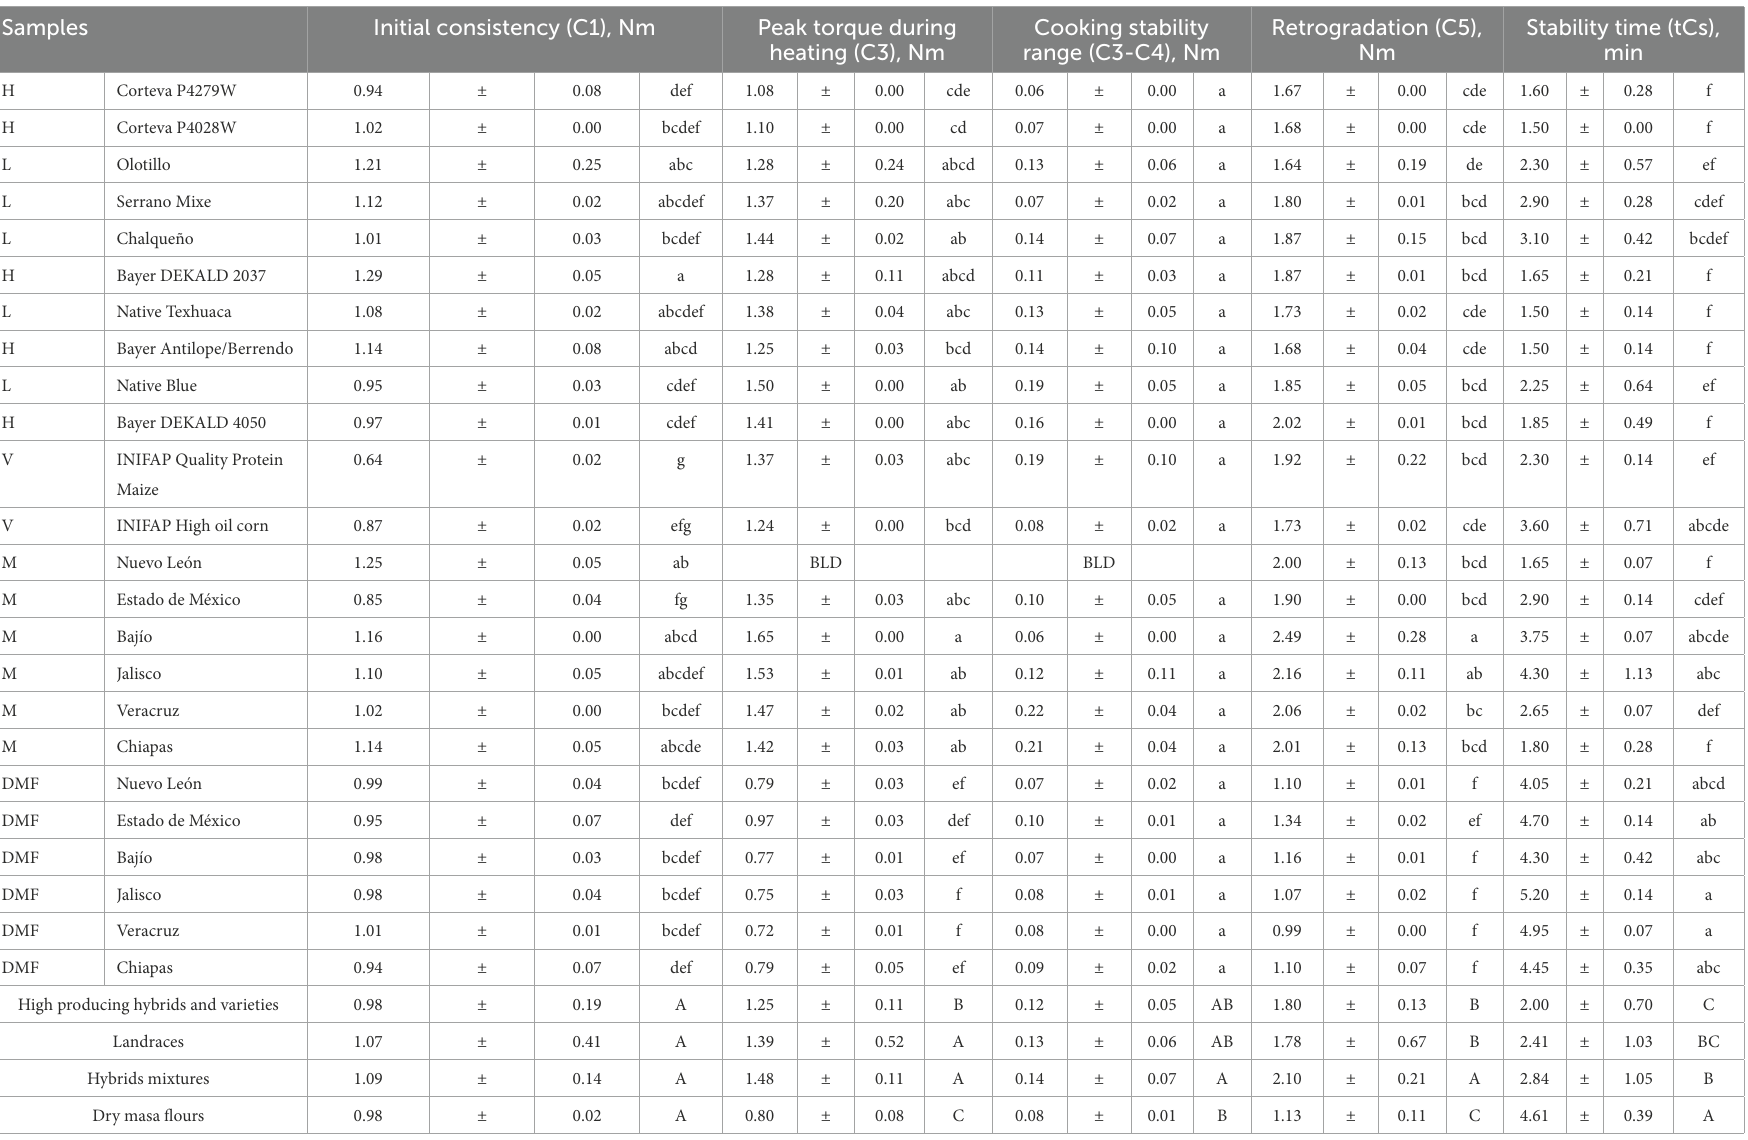
TABLE 4 Mixolab parameters of nixtamalized maize masa and